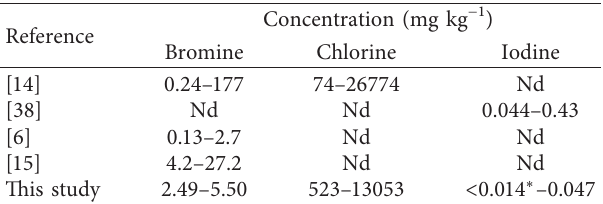
Table 5: Concentration range for bromine, chlorine, and iodine in mushrooms reported in the literature and in the samples analyzed in this